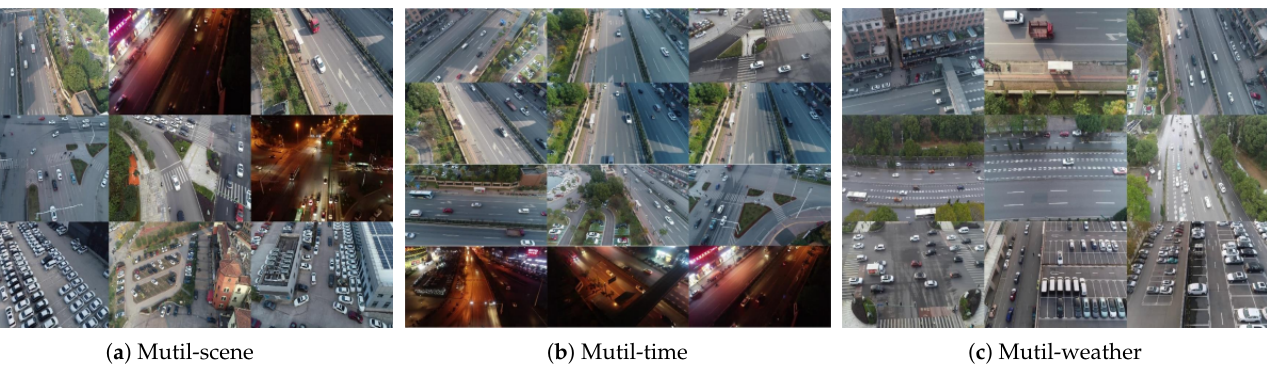
Figure 3. Images in VRU with different scenes, time, and weather.